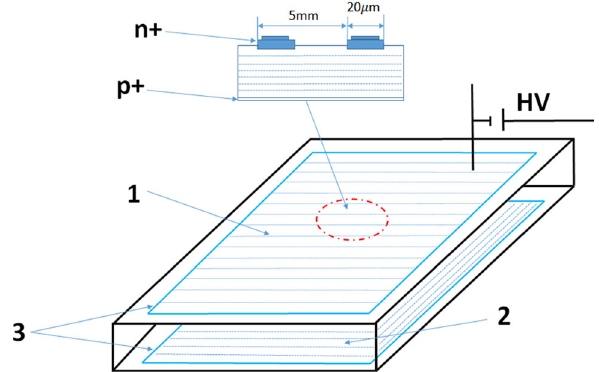
Fig. 5 Shown is a Ge detector with internal amplification [66]. The upper parts are: 1—anode strips, 2—cathode, 3—guard electrodes, the scheme of n+ and